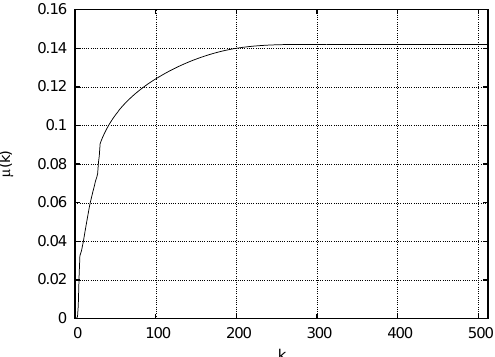
Figure 16. Steepness as a function of absolute value of wave num- ber. The condensate was